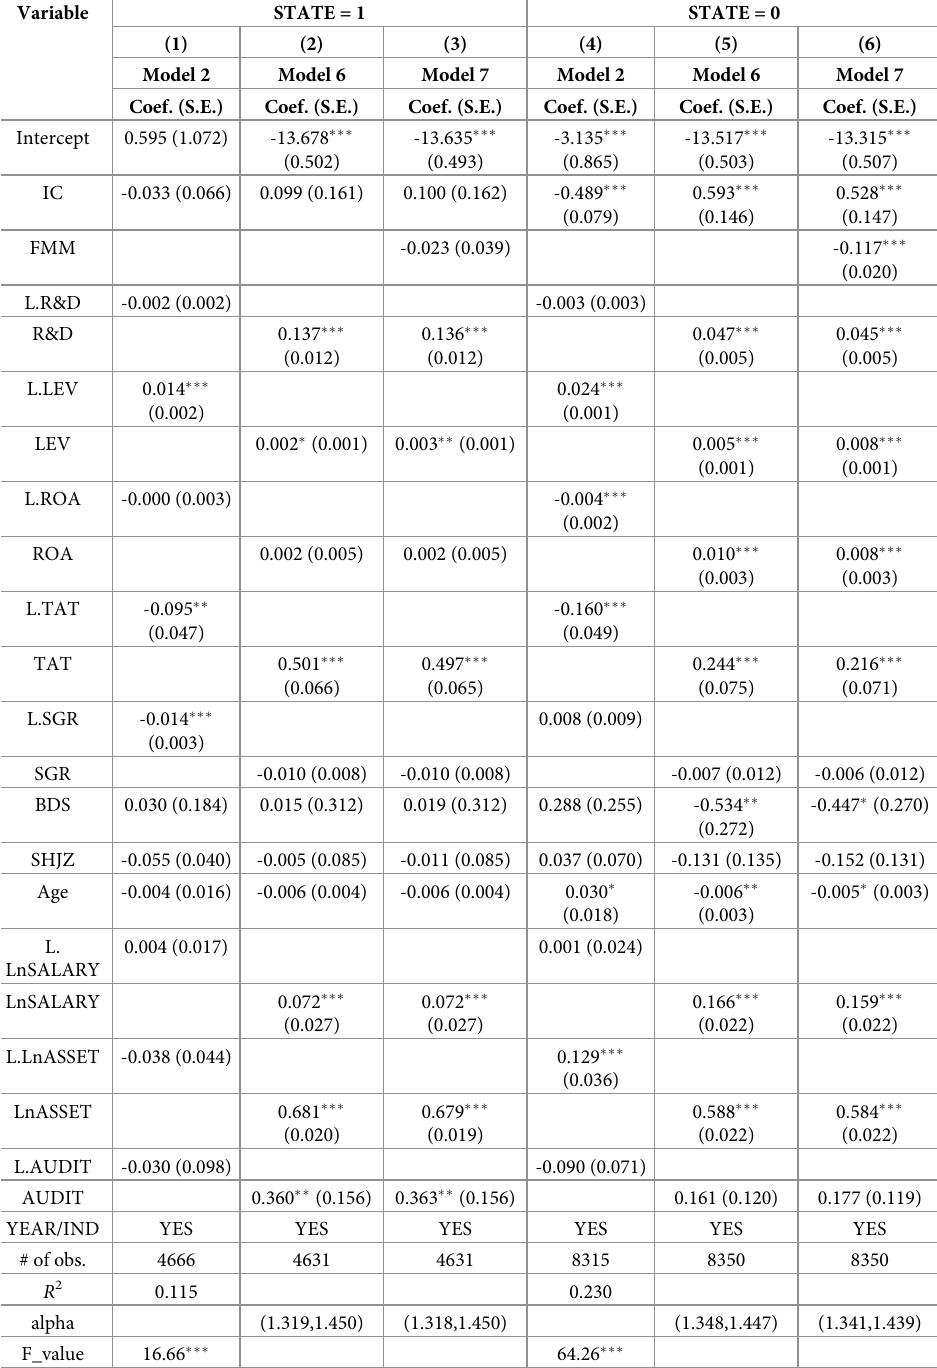
Table 10. Results for STATE = 1 and STATE =